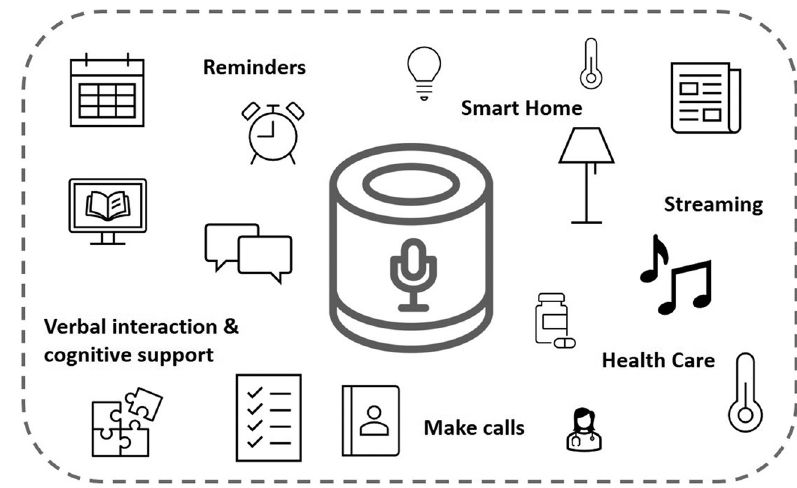
Figure 2: Robot companion that can be used for informational services and for social